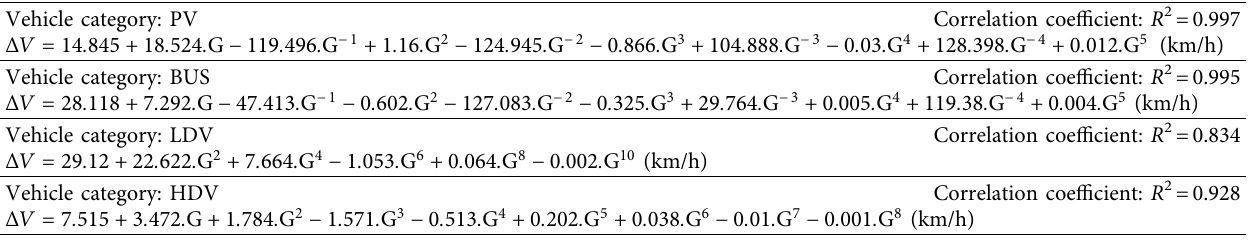
Table 6: Empirical mathematical models of functional speed deviation dependence on a longitudinal gradient. Vehicle category: PV Correlation coefficient: R 2 �